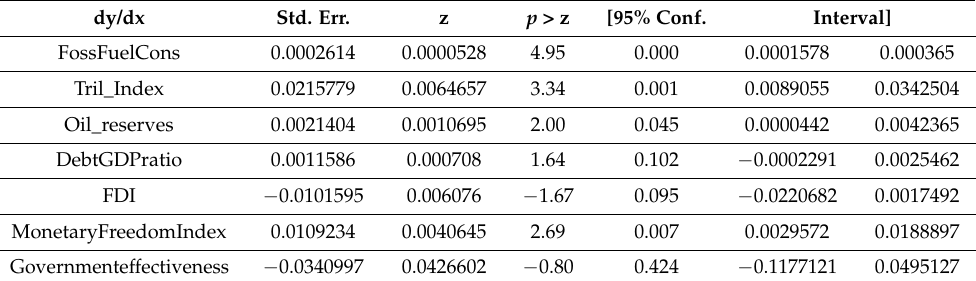
Table 7. Marginal effects after probit (Model 2).